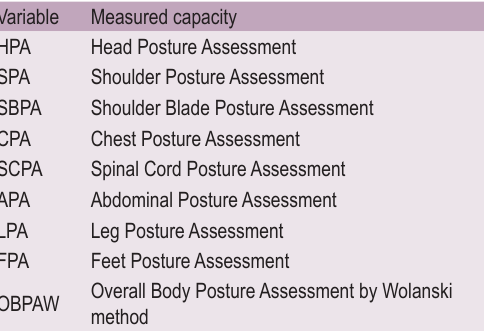
TABLE 1. Sample of